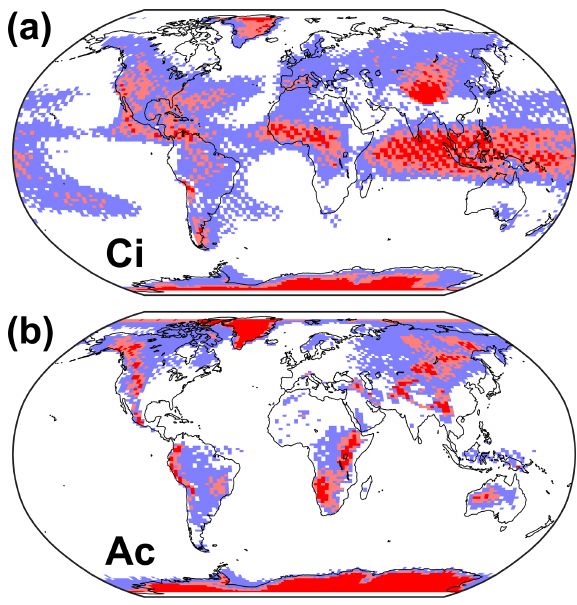
Figure 9. Overview of the best regions for placing a ground-based lidar for observing (a) high and (b) mid-level clouds derived from multiplying the data in Figs. 1a and 4a by the normalized number of profiles per grid box, i.e. Fig. 1c divided by 33955 and Fig. 4c by 27469, respectively. The colours refer to the factors for meeting suitable conditions for ground-based lidar observations of the two cloud types. For cirrus clouds, the colours mark the ranges 0.0000 to 0.0399 (white), 0.0400 to 0.0799 (light blue), 0.0800 to 0.1199 (light red), and > 0 . 1200 (red). The corresponding ranges for al- tocumulus clouds are 0.0000 to 0.0249, 0.0250 to 0.0499, 0.0500 to 0.0749, and > 0 . 0750.